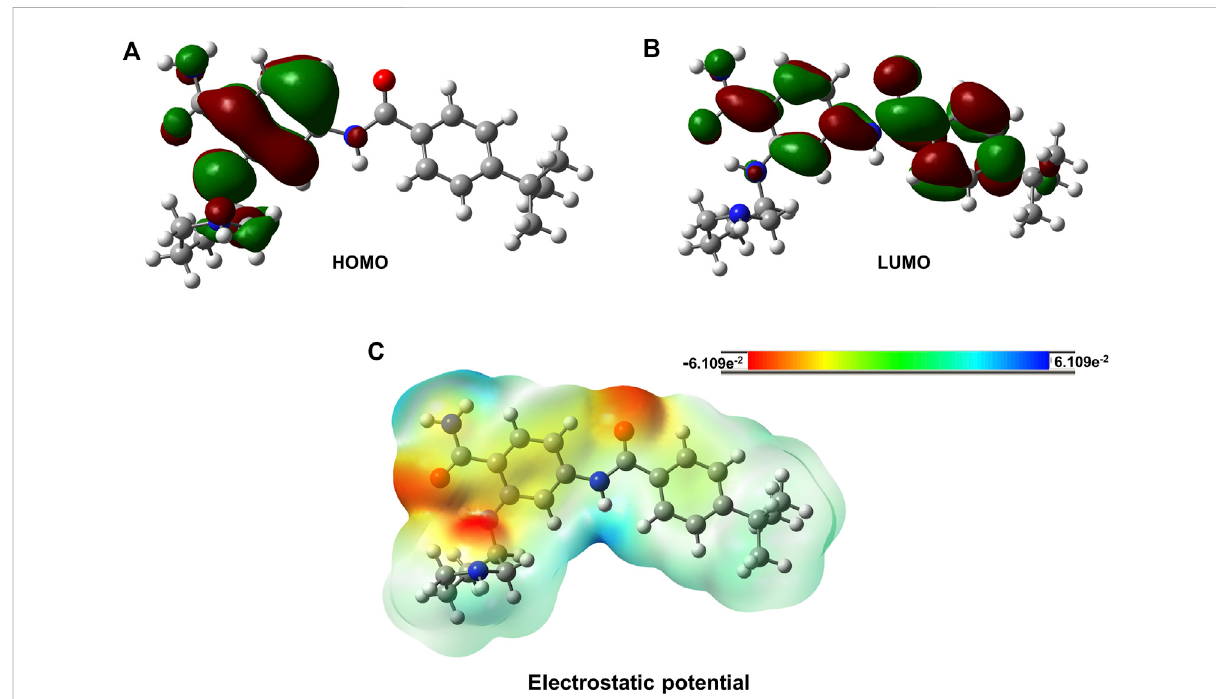
FIGURE 6 Isosurfaces of Frontier orbitals HOMO (Highest Occupied Molecular Orbital) and LUMO (Lowest Unoccupied Molecular Orbital). The charge distribution over PCW-A1001 molecule. (A) Isosurface of HOMO, (B) Isosurface of LUMO and (C) Electrostatic potential of the PCW-A1001. The red color indicates the negative charge and green color indicates the positive charge for the PCW-A1001. The electrostatic potential values were distributed from − 6.109e − 2 to 6.109e − 2 .